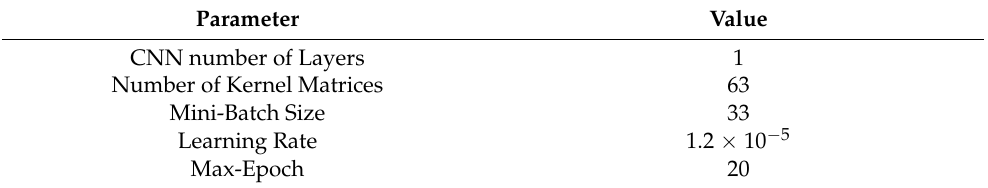
Table 2. DELFI Classifier—CNN Parameters.